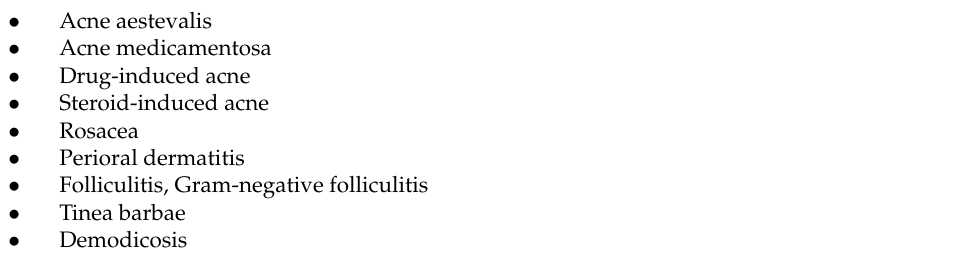
Table 3. Acneiform eruptions not being part of a systemic disease or